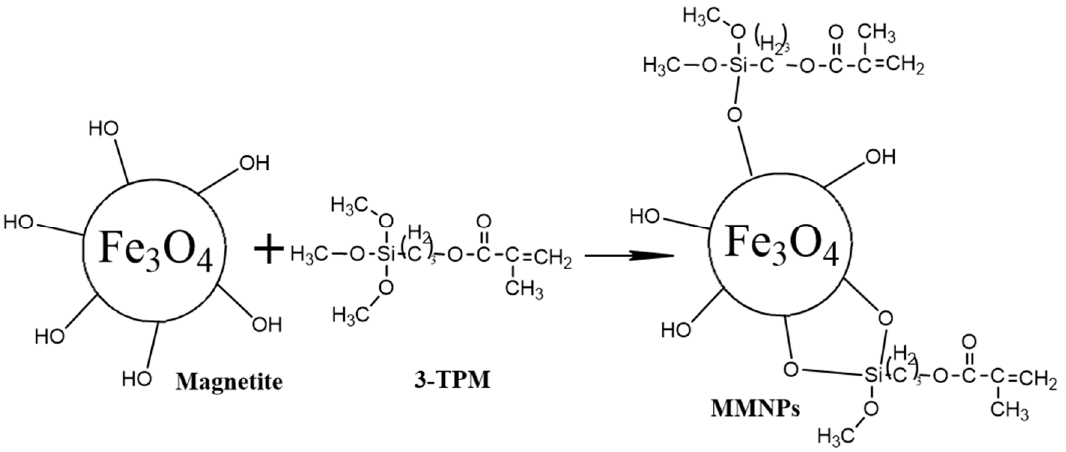
Figure 1. Modification of magnetite nanoparticles with double bonds.